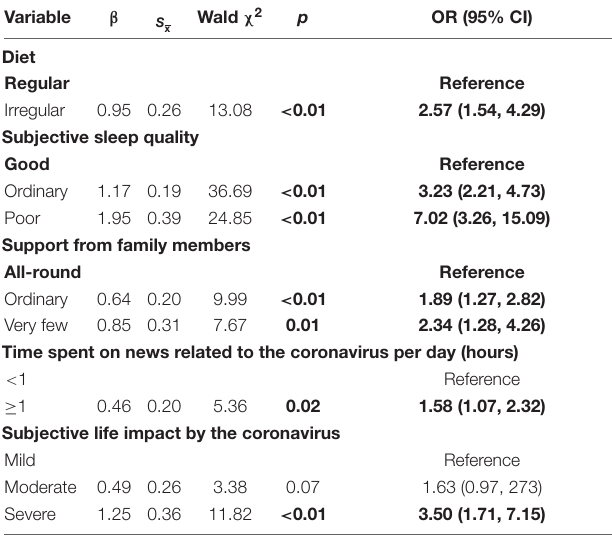
TABLE 2 | Multivariate logistic regression analysis of potential risk factors for anxiety symptoms.